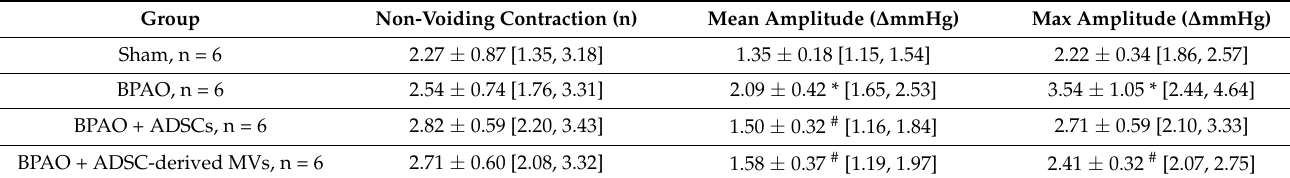
Table 4. Analysis of NVC on transcystometrogram. Data are presented as mean ± standard deviation; the 95% confidence intervals are shown in brackets. * p < 0.05 vs. sham group by two-tailed non-paired Student’s t -test. # p < 0.05 vs. BPAO group by two-tailed non-paired Student’s t